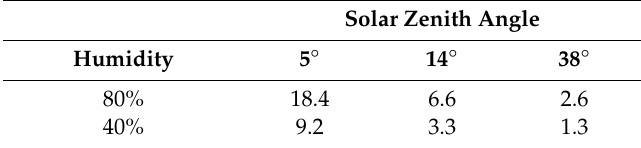
Table 3. Case study of image quality depending on solar zenith angle and humidity.